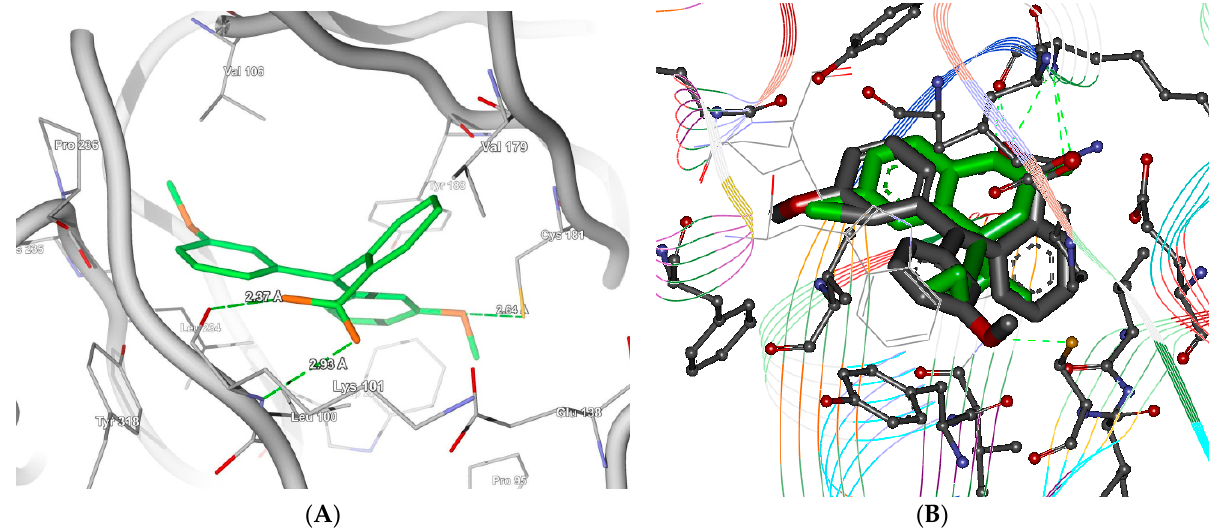
Figure 8. ( A , B ). The comparative docking of screened ( A ) ligand (NCI-21270) and ( B ) Nevirapine as a standard drug shows butterfly conformation and important hydrophobic interactions, along with hydrogen-bond interactions with Lys101 and other important residues in the NNRTI’s binding site. Table 3. Docking scores of reference compounds and the final hits obtained after the docking study.